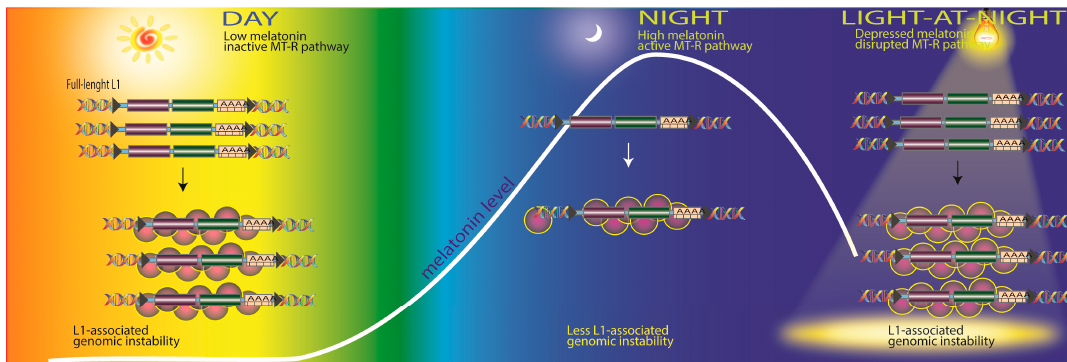
Figure 3. This figure illustrates the likely role of melatonin in influencing L1 expression and DNA damage. During the day ( left ) which circulating melatonin levels are at their nadir, L1 mRNA causes L1-mediated DNA damage. At night in darkness ( center ), the elevation of melatonin in the blood acts on the MT1 melatonin receptor to suppress L1 mRNA and ORF1 (open reading frame) protein. By this means, melatonin reduces L1-associated genomic stability thereby reducing the risk of cancer. Contaminating the night with light reduces melatonin levels leading to high L1 mRNA and protein expression causing L1-mediated DNA damage ( right ).